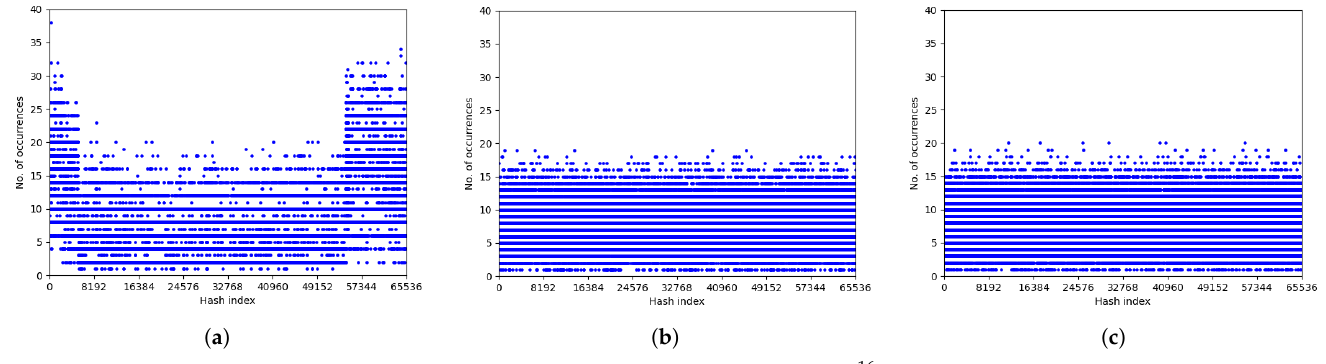
Figure 12. Visualization of bucket occupation for 2 16 buckets. ( a ) Mod32; ( b ) modified Vermont;